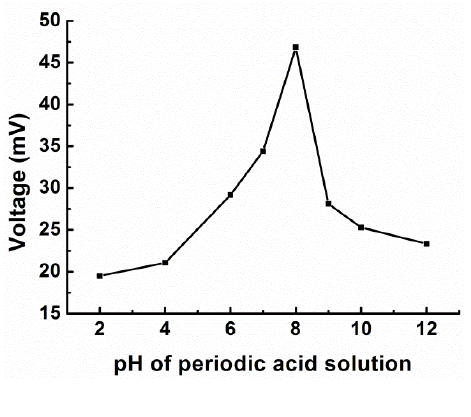
Figure 5. Effect of pH of H 93.75 mg/L glucose solution was tested using a 0.03 M H 0.6 mL/min.